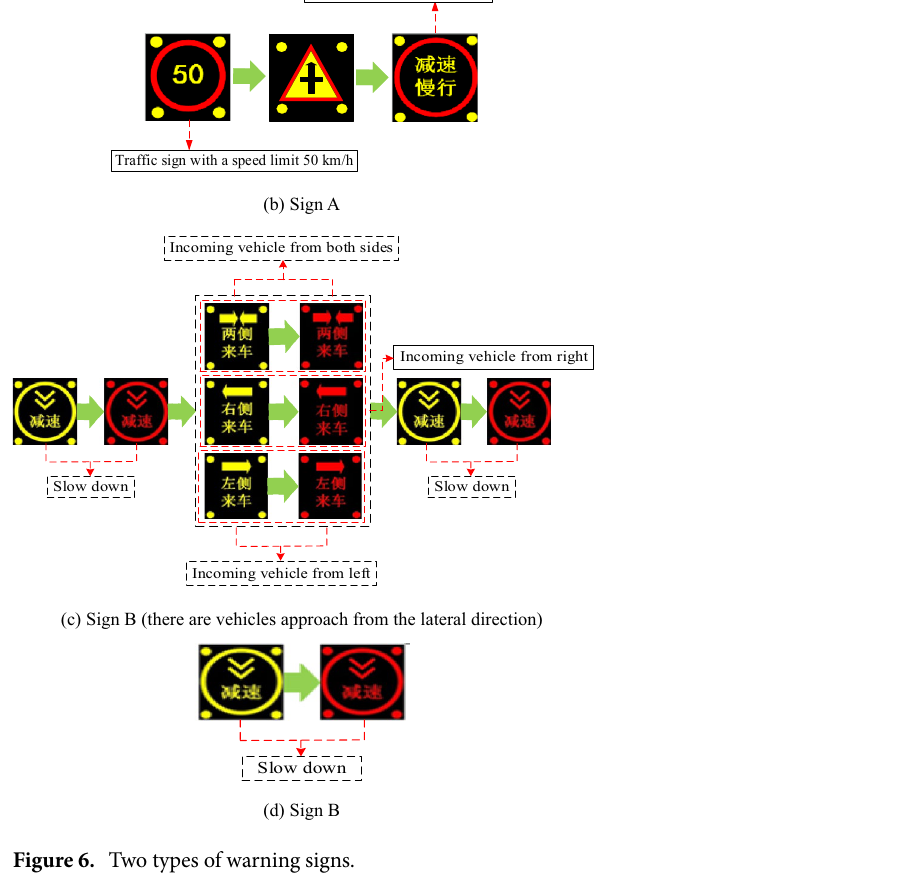
Figure 6. Two types of warning